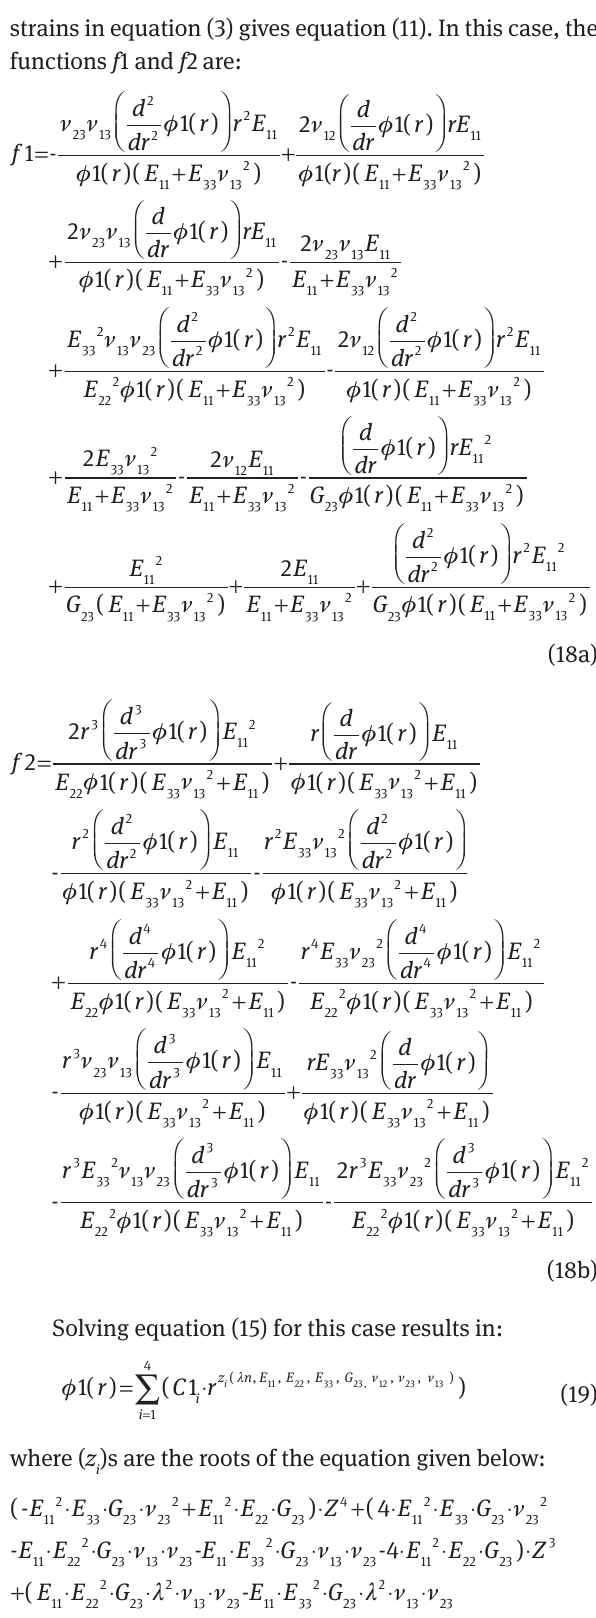
Figure 3: Pressure profile in a non-frictional